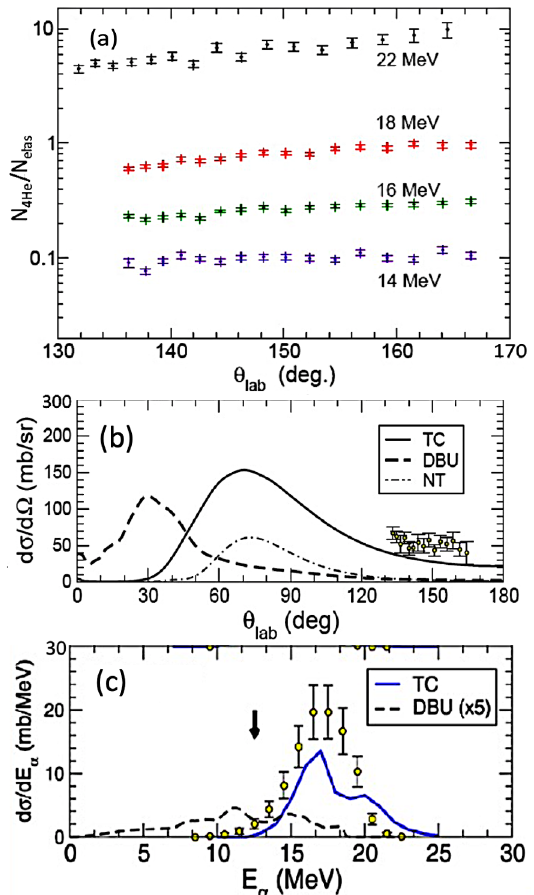
Fig. 2. (a) Angular distribution of the relative yields N 4He /N elas in a range of collision energies between 14 MeV - 22 MeV. (b) Angular distribution of the cross section for 4 He fragment production. (c) Energy distribution of 4 He fragments for the angular range 132°-164°. The black arrow in panel 2(c) marks the energy of ~ (4/6) E Lab where the events arising from direct breakup should be expected. See text for discussion.